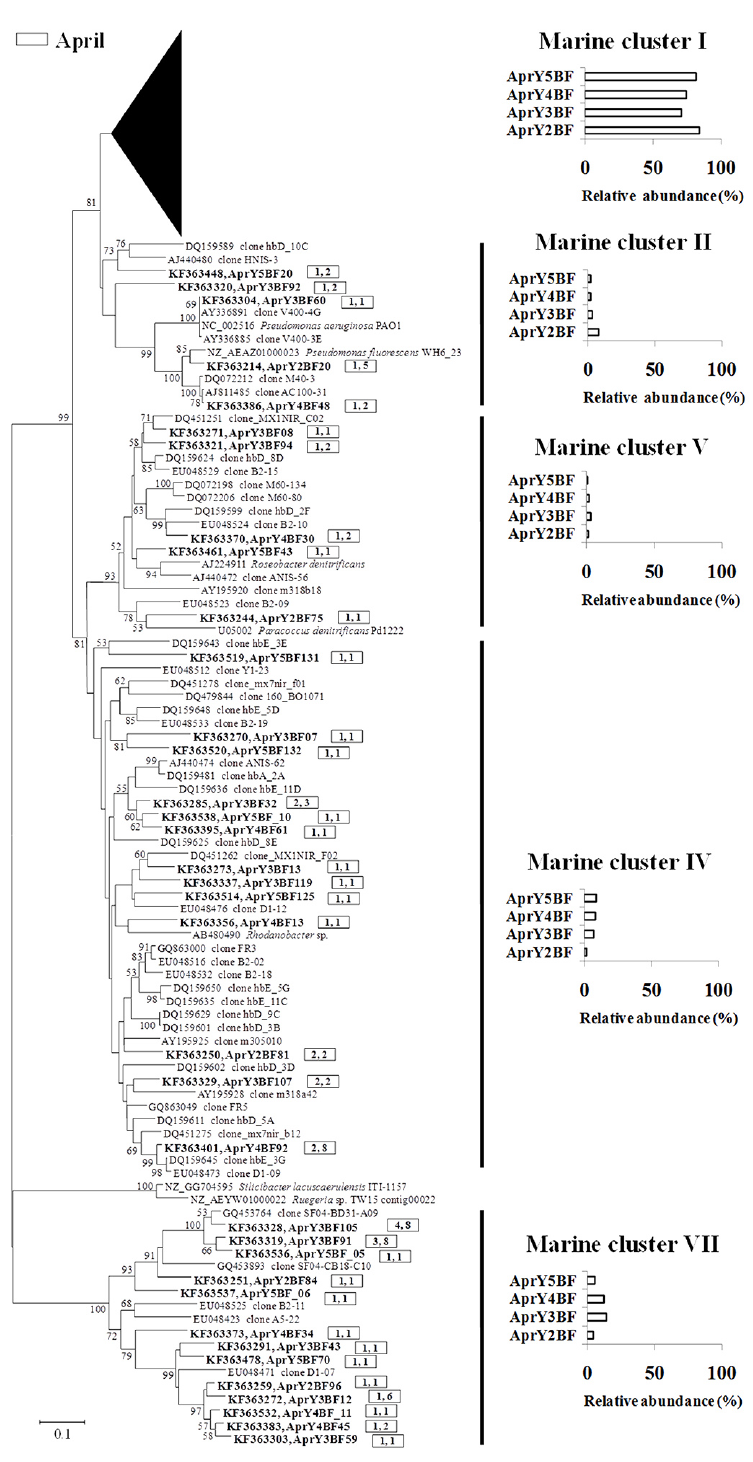
Fig. 5. Phylogenetic tree of nirS constructed based on amino acid sequences using the neighbor-joining method. Sequences from this study are shown in bold, and sequences sharing 95% DNA identity are grouped. In these groups, the number of samples and sequences is shown in the frame. The relative abundance of clones retrieved for each clone library in the five clusters is indicated by the bar. GenBank accession numbers are shown. Phylogenetic relationships were bootstrapped 1000 times, and bootstrap values greater than 50% were shown. Scale bar represents the amino acid substitution